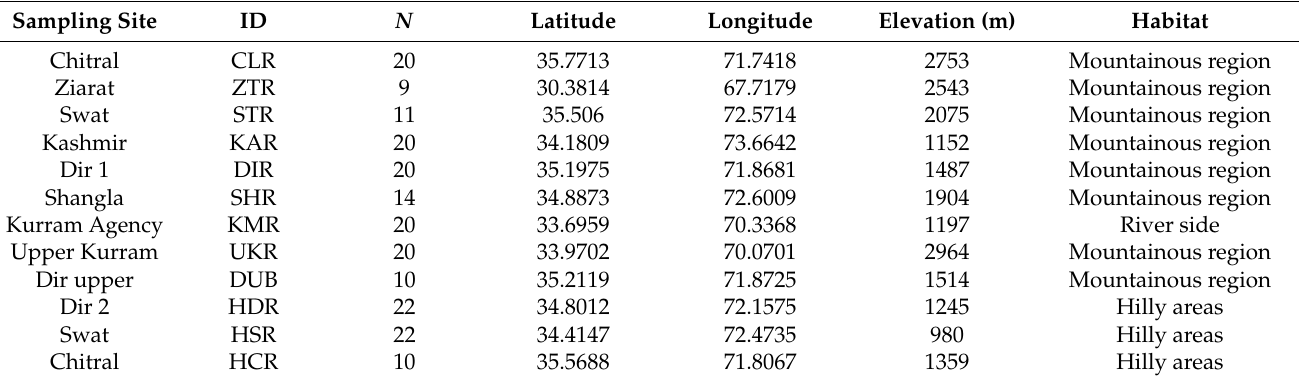
Table 1. Sampling information of 12 populations of J . regia from